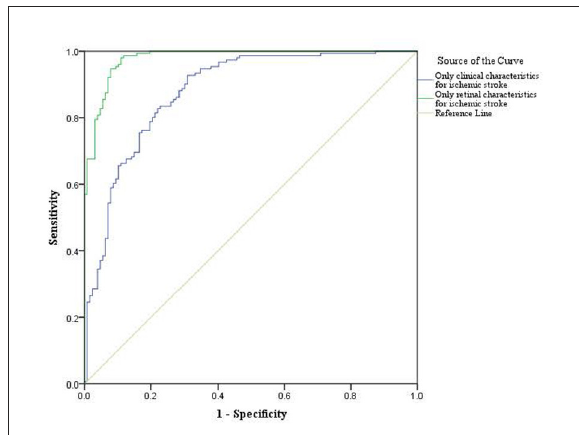
FIGURE2 ROC curves of the model using only clinical characterisitics and model using only retinal characteristics for ischemic stroke risk estimation.